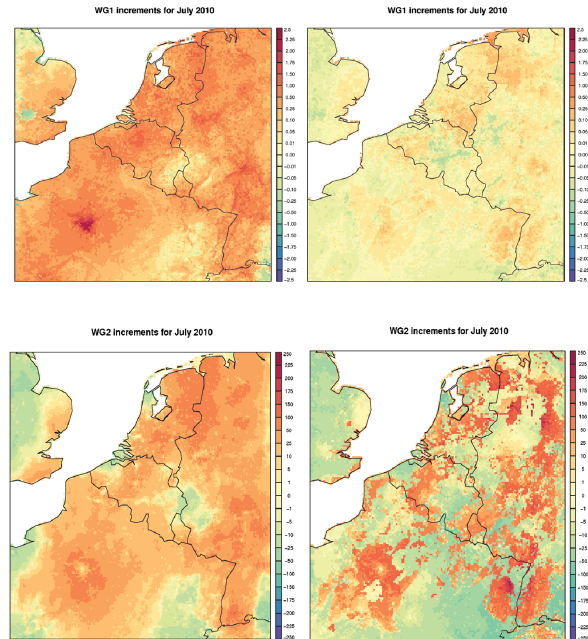
Fig. 13. Soil moisture increment (mm) accumulated over the month of July 2010. Top left: superficial produced by OI analysis; top right: superficial produced by the EKF analysis; bottom left: deep pro- duced by OI analysis; and bottom right: deep produced by the EKF analysis.